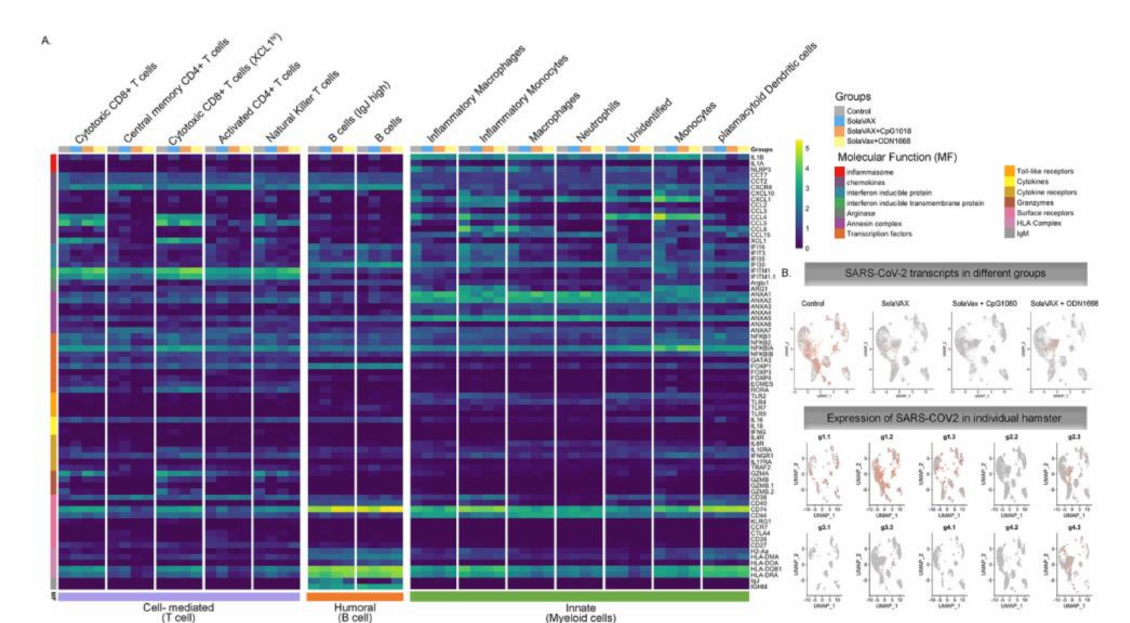
Figure 8. Average log fold change gene expression analysis. ( A ) Average log fold change gene expression comparing pooled gene expression between Control, SvX, CpG, and ODN for different molecular functions across different cell types. Column annotation bar at the top represents different groups, column annotation bar at the bottom represents major immune response type and row annotation bar on the left represent different molecular functions. Cell types are annotated above each cluster in the heatmap. ( B ) Expression of SARS-CoV-2 transcripts in different groups when merged ( top panel ) and in each individual hamster ( bottom panel ).